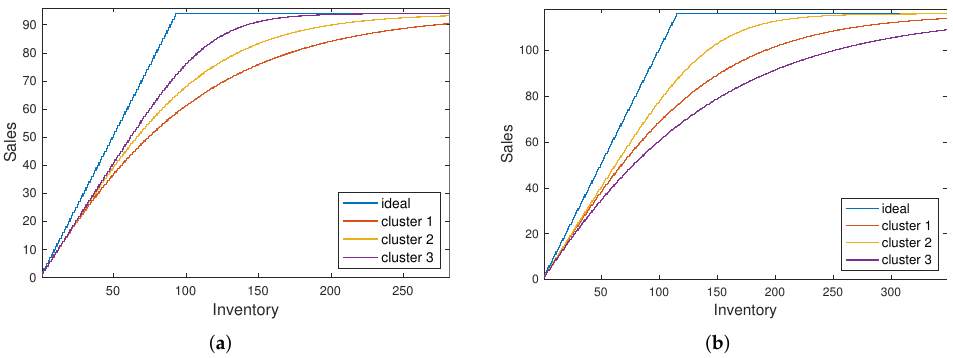
Figure 3. Sales forecast related to inventory of the dataset on shoes and belts compared with the ideal conversion rate of sales. ( a ) Shoes (mean D = 94) (The mean D is the rounding of the average demand of all samples in the corresponding dataset). ( b ) Belts (mean D =